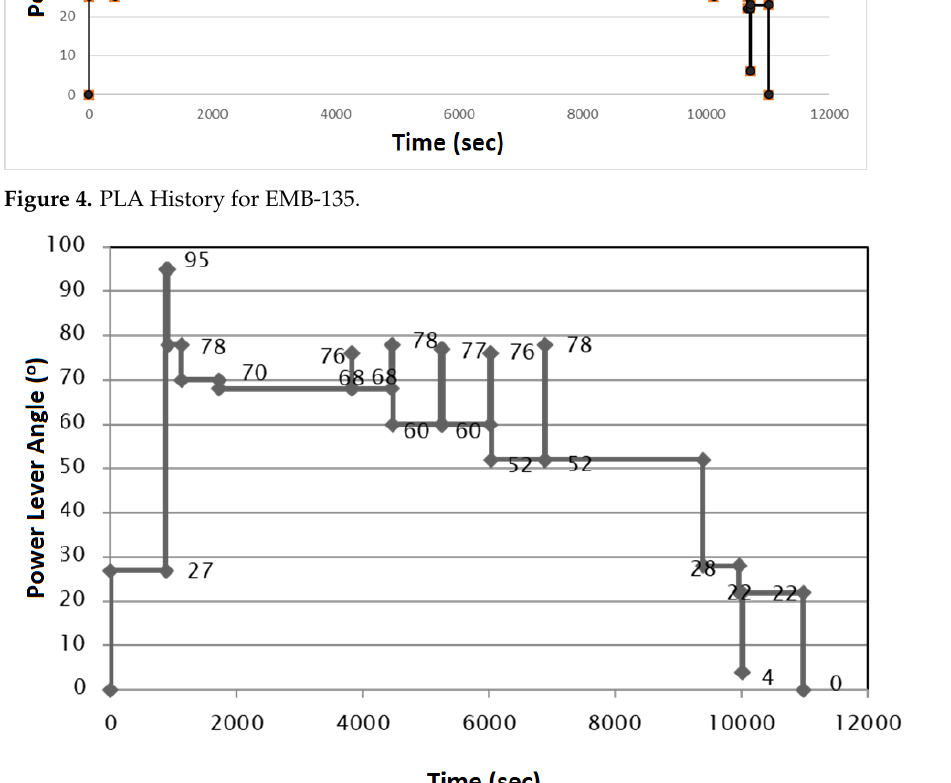
Figure 5. PLA History for